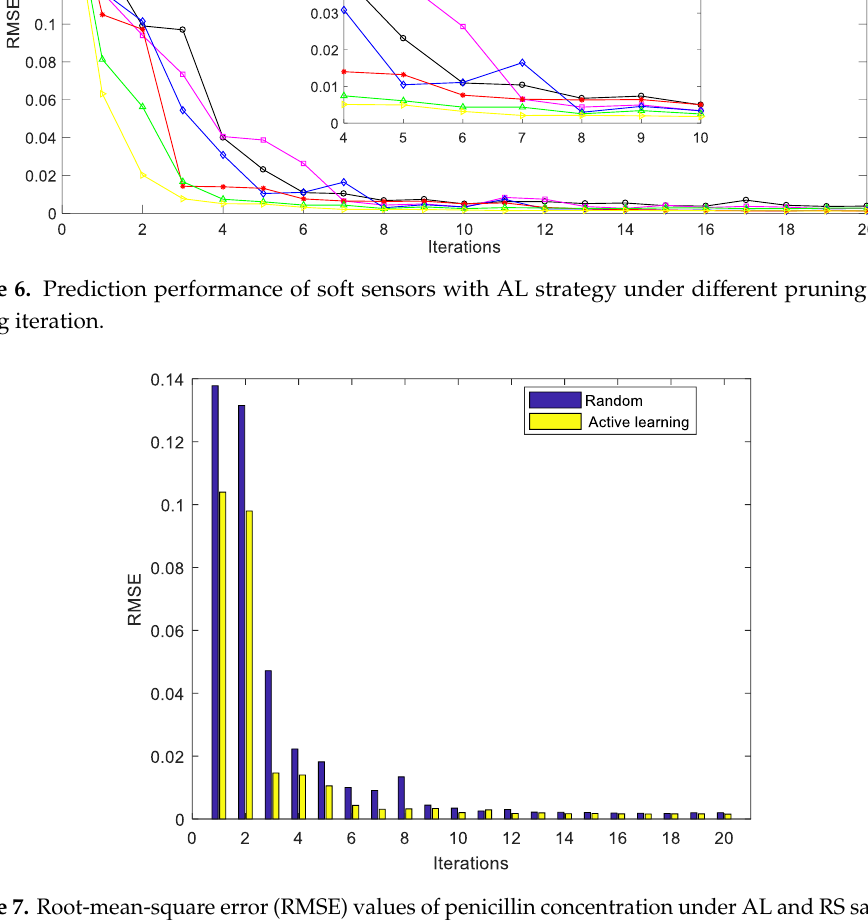
Figure 7. Root-mean-square error (RMSE) values of penicillin concentration under AL and RS sampling strategies during iteration.